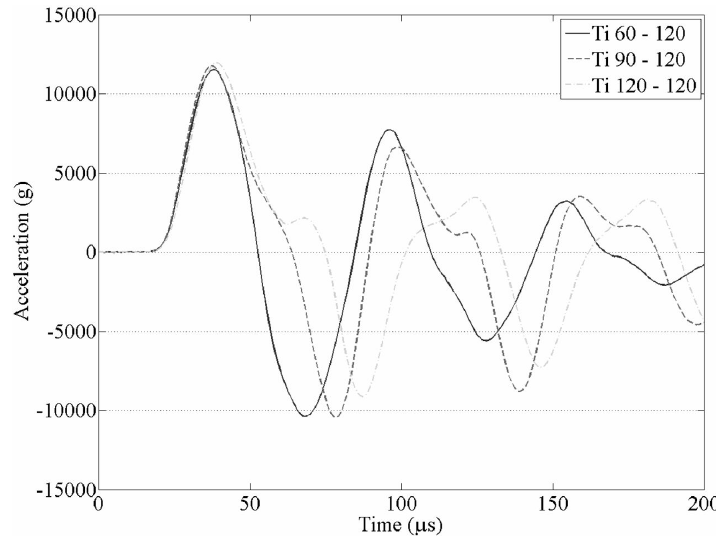
Fig. 6. VAMP acceleration traces for a series of titanium striker rod lengths and an impact velocity of 3.5